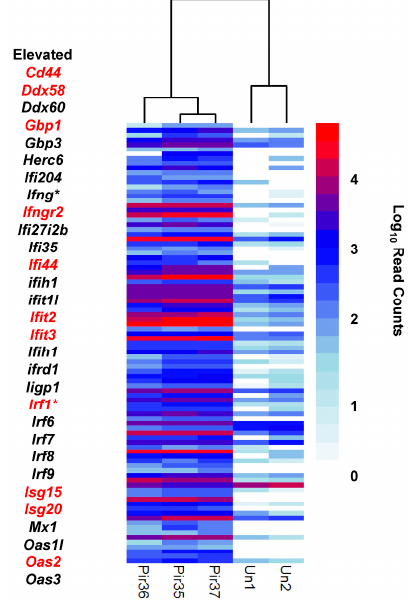
Figure 6. Interferon response. Differential expression (DESeq) data was plotted by cluster analysis with R software (pheatmap). Infected (Pir35, Pir36, Pir37) and uninfected (Un1, Un2) hamster livers. Histogram shows read count densities (log10) for 93 transcript isoforms or alleles from 34 unique genes. Selected transcripts from this set are listed to the left of the histogram; starred transcripts are expected to occur during the pro-inflammatory macrophage M1 response; transcripts in red font are enriched in the infected vs. uninfected liver dataset of Djavani et al. [16].